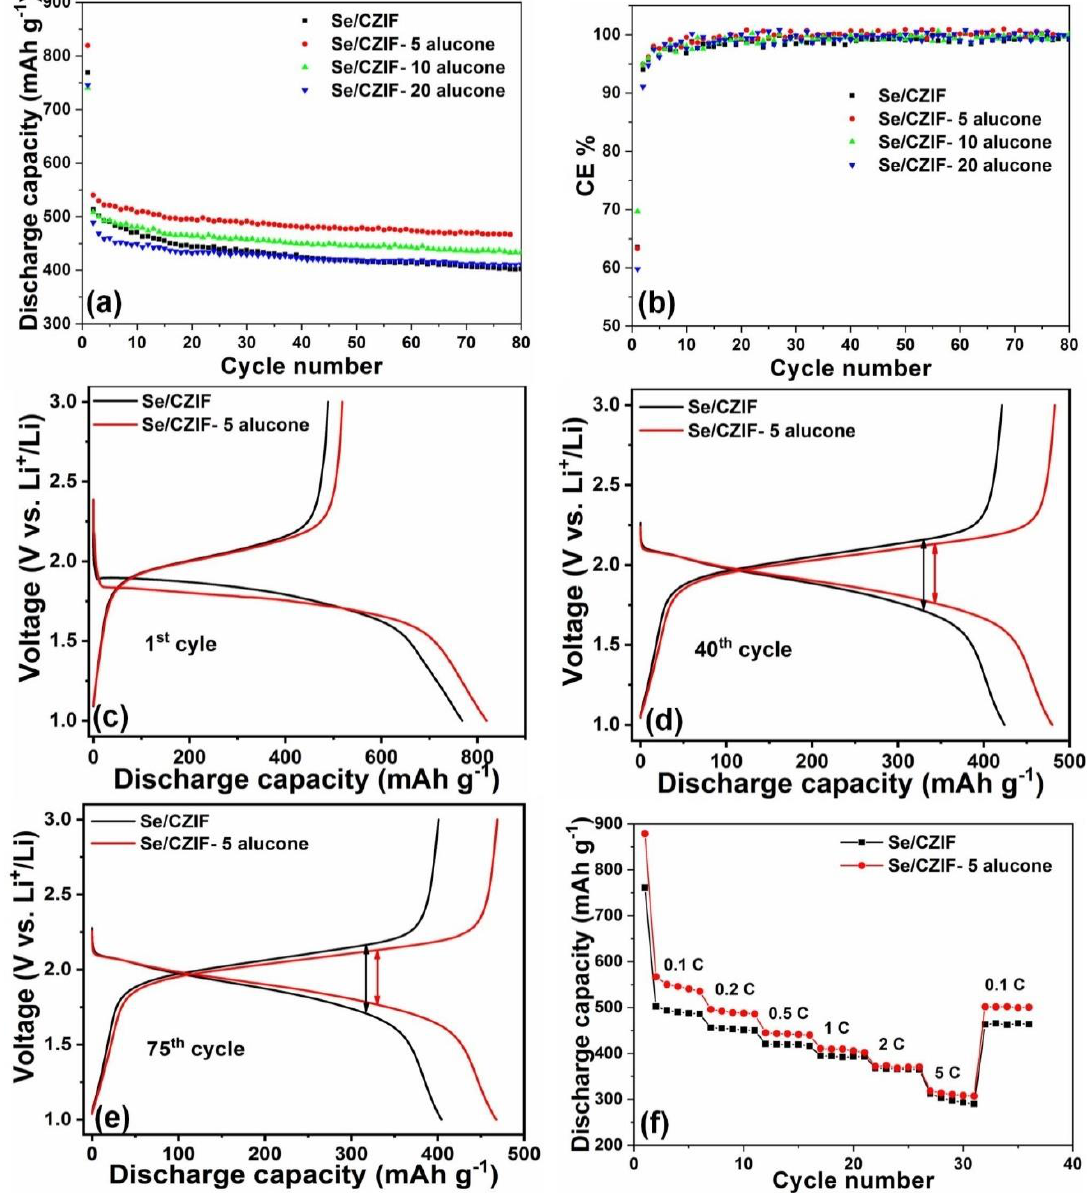
Figure 3. ( a ) Cycling performance and ( b ) Coulombic efficiency of Se/CZIF, Se/CZIF − 5 alucone, Se/CZIF − 10 alucone, and Se/CZIF − 20 alucone measured at 0.1 C (1 C = 678 mA g − 1 ); charge–discharge profiles of Se/CZIF and Se/CZIF − 5 alucone in the ( c ) 1st cycle, ( d ) 40th cycle, and ( e ) 75th cycle; ( f ) rate capability of Se/CZIF and Se/CZIF − 5 alucone.